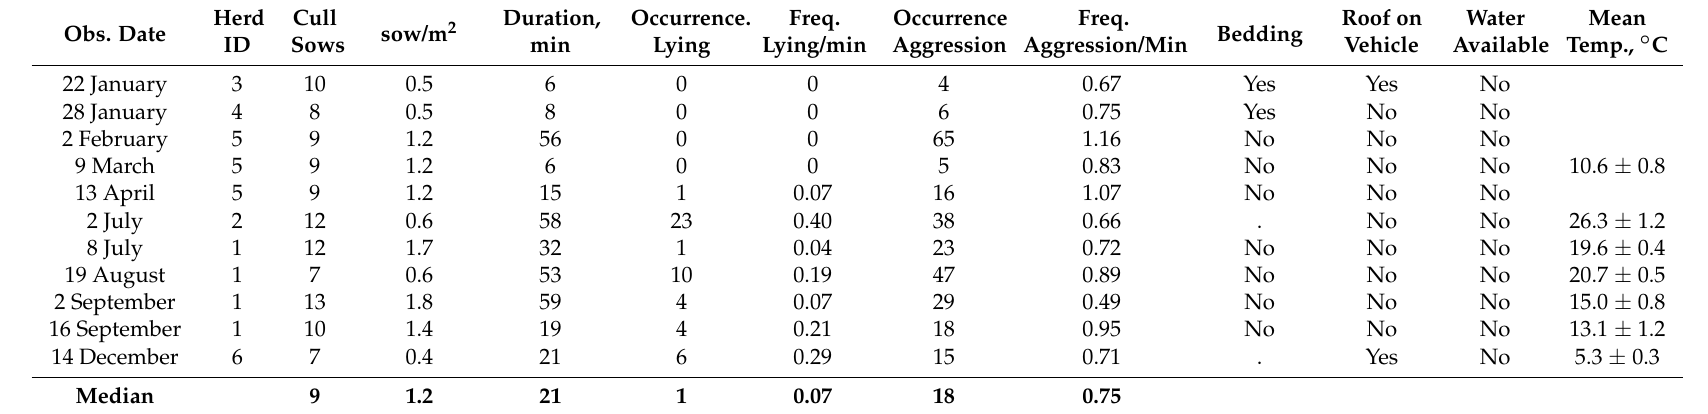
Table 1. Description of the behaviour of cull sows from 11 loads from six commercial Danish sow herds while waiting in transfer vehicles before transport to the abattoir. In addition, the observation date (Obs. Date), herd ID, duration of the stay in the vehicles, stocking density, provision of bedding (sawdust), the presence of a roof on the vehicles (yes/no), access to water (yes/no) and mean temperatures (Temp.) are shown. Obs.